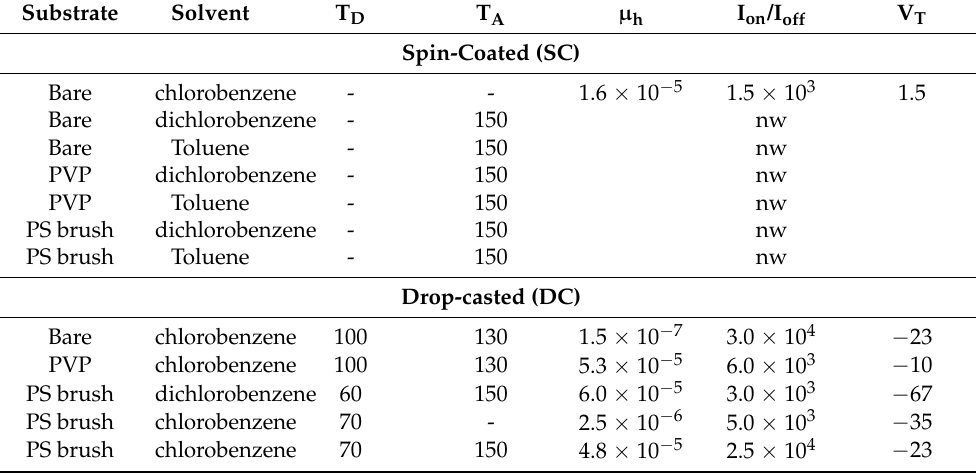
Table 3. Hole mobilities (cm 2 /V − 1 s − 1 ), current on/off ratios (I on /I off ), and threshold voltages (V T , V) for films deposited at various substrates, substrate temperatures (T D, ◦ C) and annealing temperatures (T A , ◦ C); nw: not